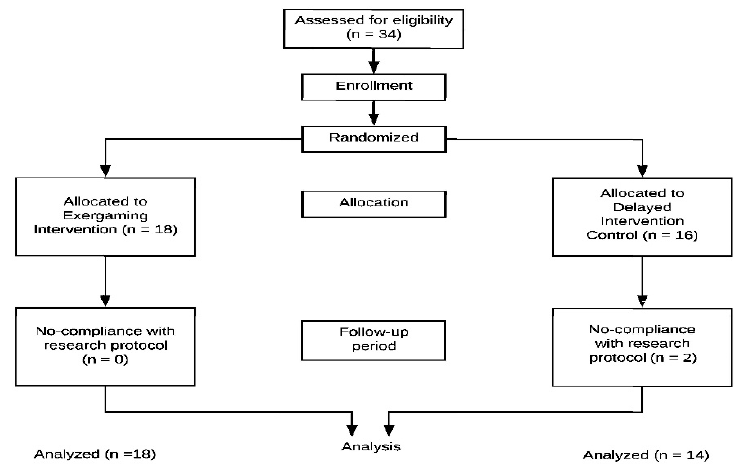
Figure 1. Chart of the trial.